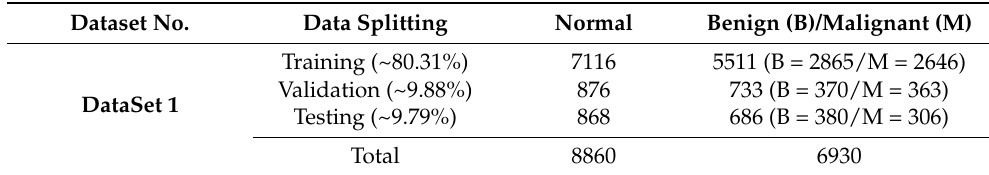
Table 3. Splitting based on patient level to create patches and without augmentation for normal and abnormal.